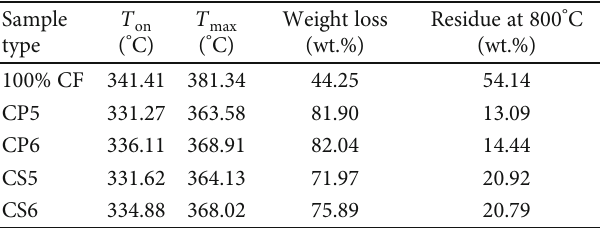
Figure 2: DTG curve on the e ff ect of hybridization of woven kenaf in kenaf/carbon fi bre hybrid woven composite on thermal properties. Table 3: Characteristic temperature at elevated weight